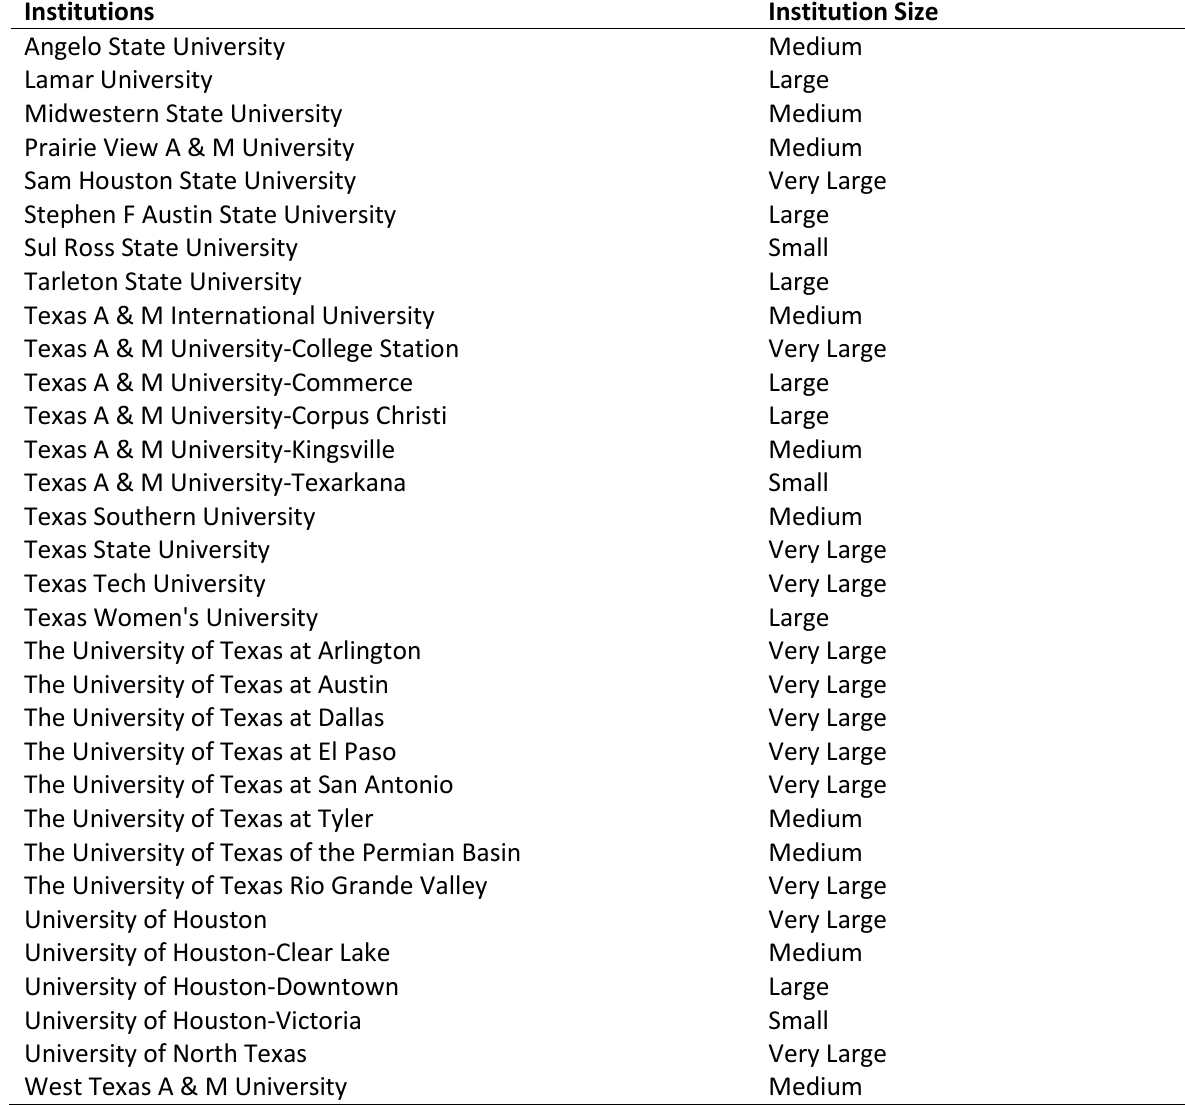
Table 2: Texas Public Four-year Higher Education Institutions by Institution Size